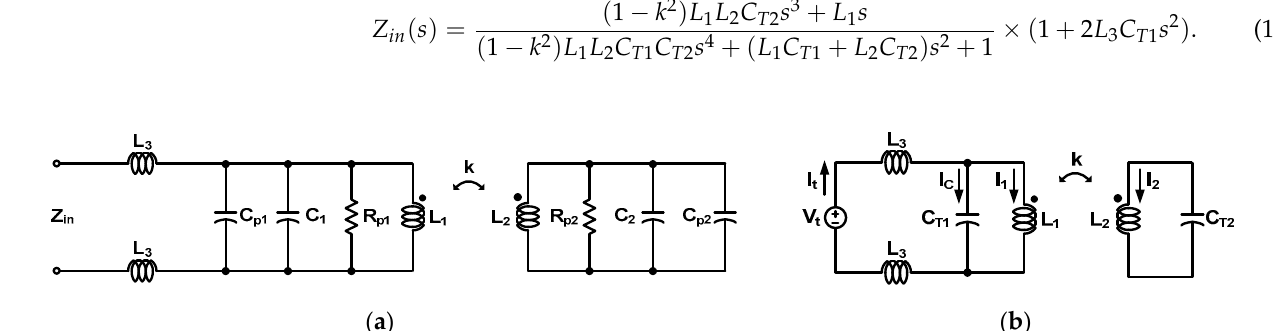
Figure 7. ( a ) Simulated magnitude plot and ( b ) phase plot of the fourth-order resonator-based ILFD and proposed CR- ILFD.